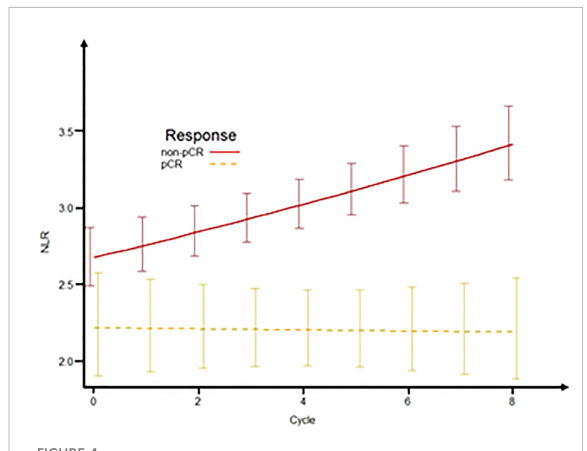
FIGURE 4 Predictive NLR over time according to response status. The plot of the mixed-effects model to predict NLR by response status (pCR and non-pCR) over time. NLR, neutrophil-to-lymphocyte ratio; pCR, pathologic complete